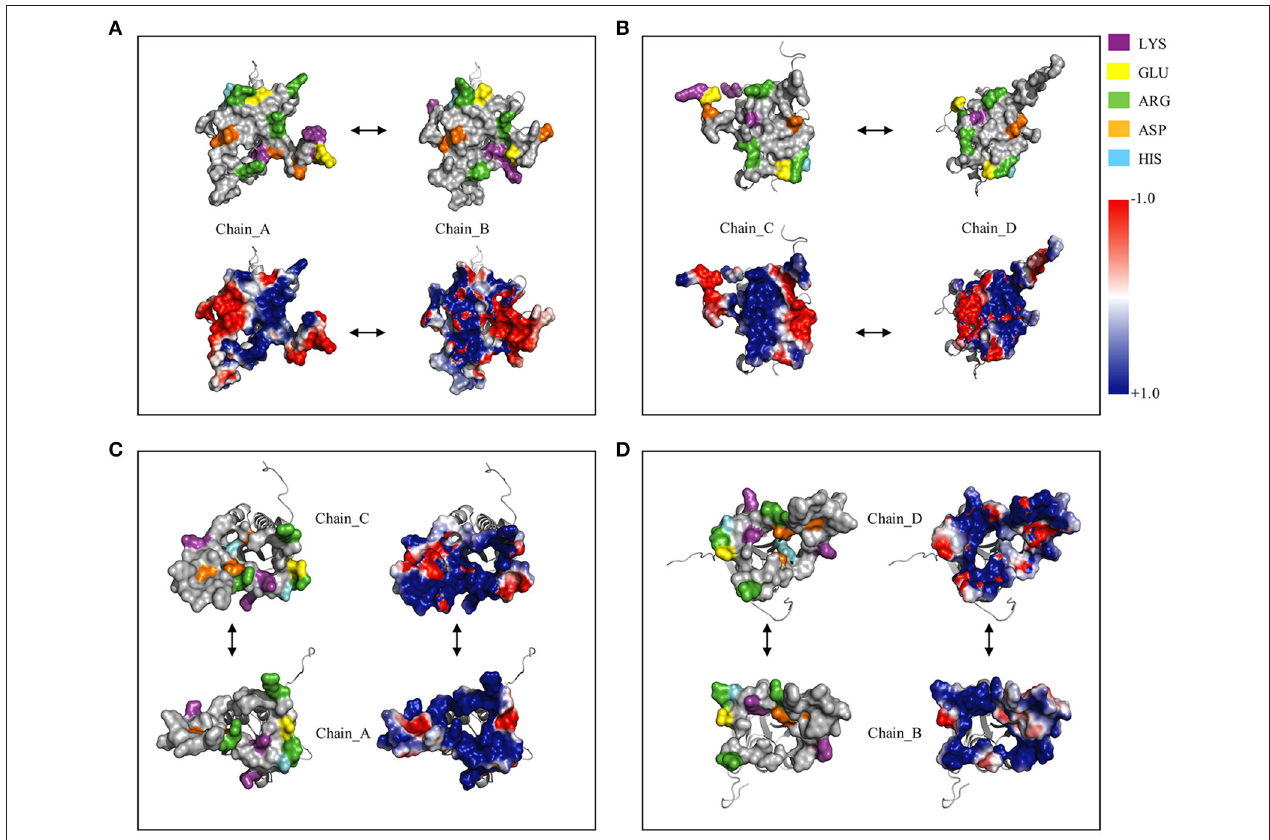
FIGURE 8 | Surface charged residues and electrostatic potential distribution at dimer and tetramer interfaces. (A), Complex between the chain_A and chain_B; (B) , complex between the chain_C and chain_D; (C) , complex between the chain_A and chain_C; (D) , complex between the chain_B and